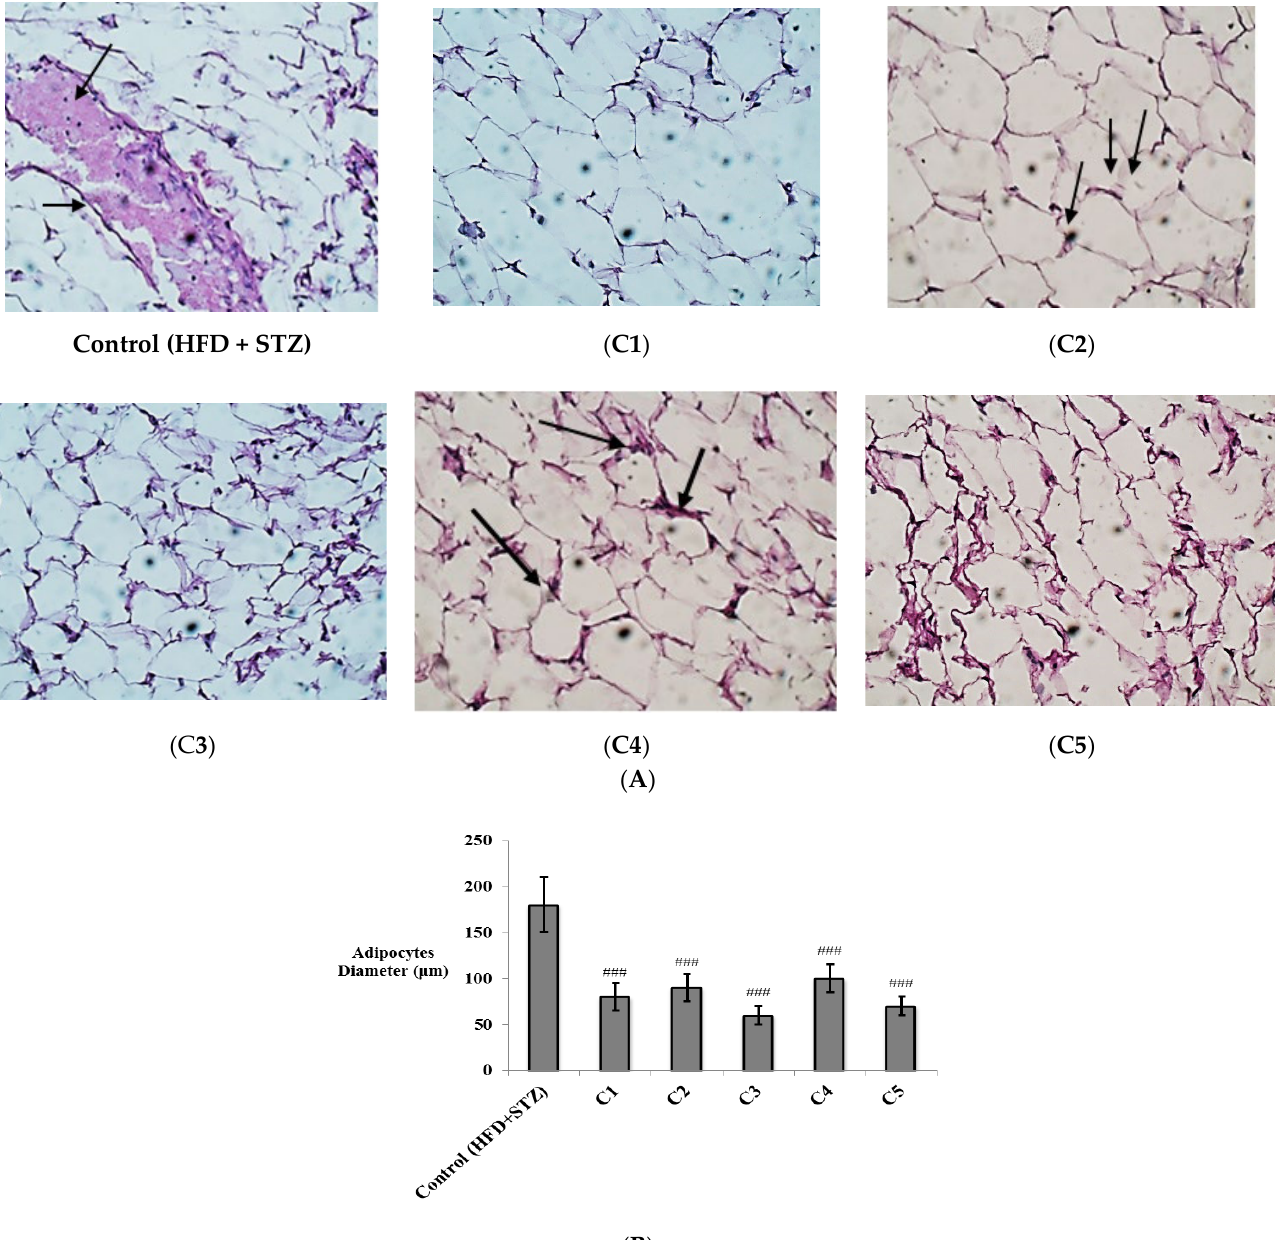
Figure 6. The histopathological study of adipose tissues from different study groups. ( A ) Photomicrographs of adipose tissues from different experimental groups stained by hematoxylin and eosin (H&E) and examined with magnifying power (40×). HFD + STZ control group; adipose tissue showed many congested vessels (Black arrows) (H&E, 40×). ( C1 ): Rutin-treated group; adipose tissue showed uniform fat cells, with non-congested blood vessels (H&E, 40×). ( C2 ):